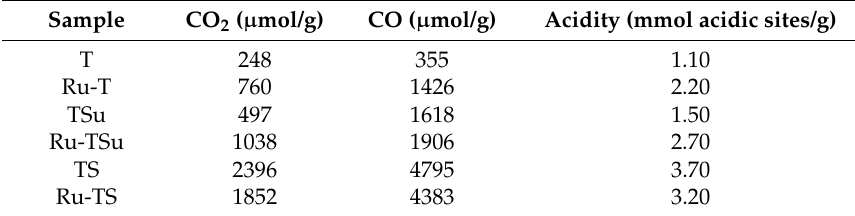
Table 2. Quantification of temperature programmed desorption (TPD) profiles and acidity determined by